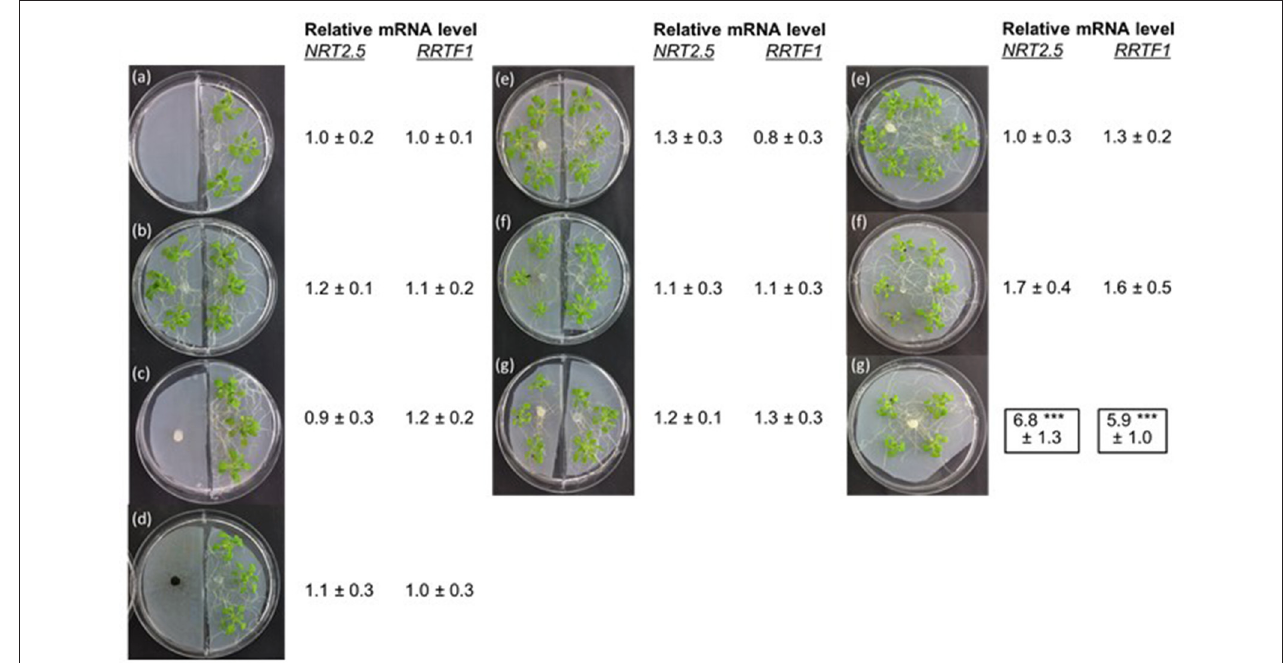
FIGURE 5 | NRT2.5 and RRTF1 mRNA levels in Arabidopsis seedlings grown in the right chamber of a split Petri dish. The other chamber contained either PNM medium alone (a), or PNM medium with Arabidopsis seedlings (b), P. indica (c), or A. brassicae (d) hyphae or Arabidopsis seedlings co-cultivated with the fungi, as described in the legends to the Figures 2 , 3 (e, P. indica alone, f, Arabidopsis infected with A. brassicae spores, g, Arabidopsis seedlings exposed to both fungi). The organisms grown in the three Petri dishes on the right site were not separated from each other. RNA extraction was performed 12 days. The mRNA levels of Arabidopsis seedlings with only PNM medium in the neighboring chamber was set as 1.0 and all other values are expressed relative to them. Based on 6 independent experiments with 10 seedlings for each